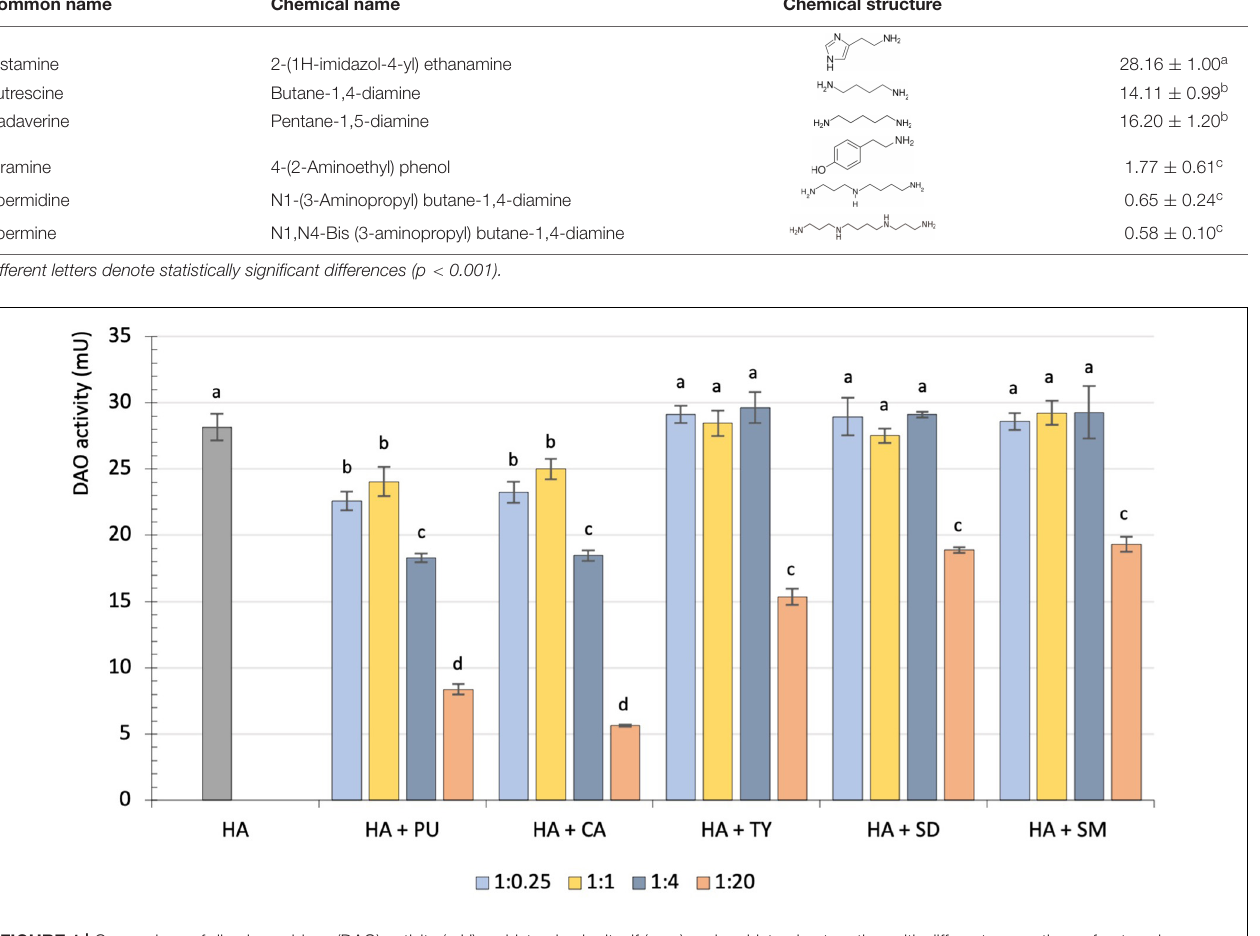
Frontiers in Nutrition |